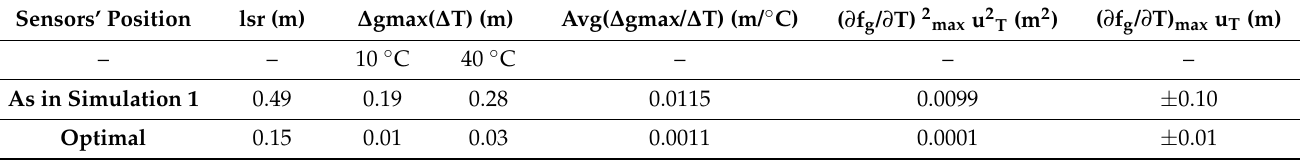
Table 2. The comparison of the contributions of the oil temperature to the combined measurement uncertainty in the second simulation. The improvement by one order of magnitude in the contribution from the starting position of the AE sensors to the optimal position.